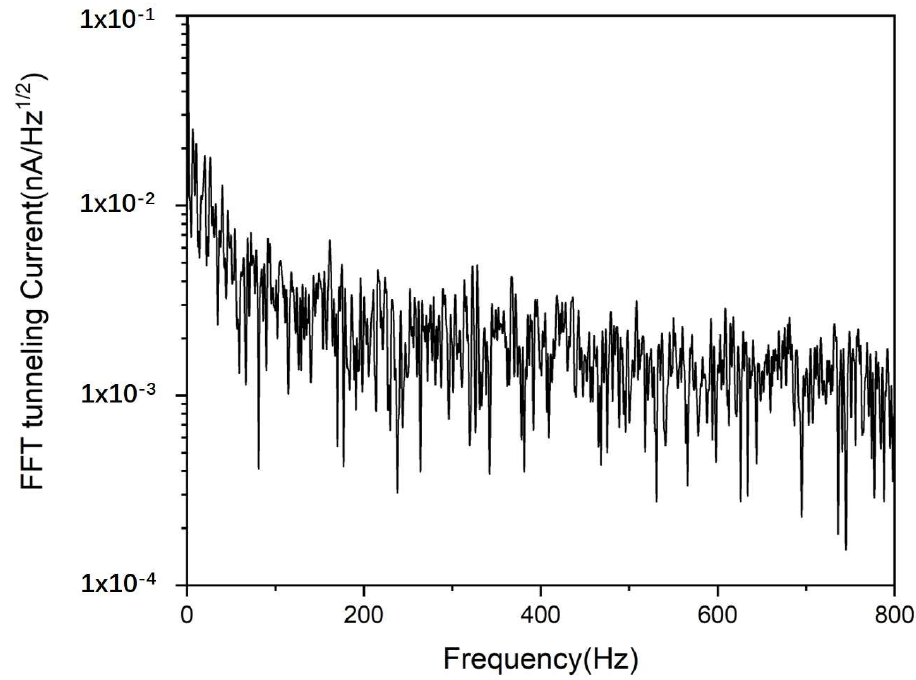
Figure 4. Base noise obtained by acquiring the tunneling current with feedback loop open. The tunneling current is set as 2.5 nA.